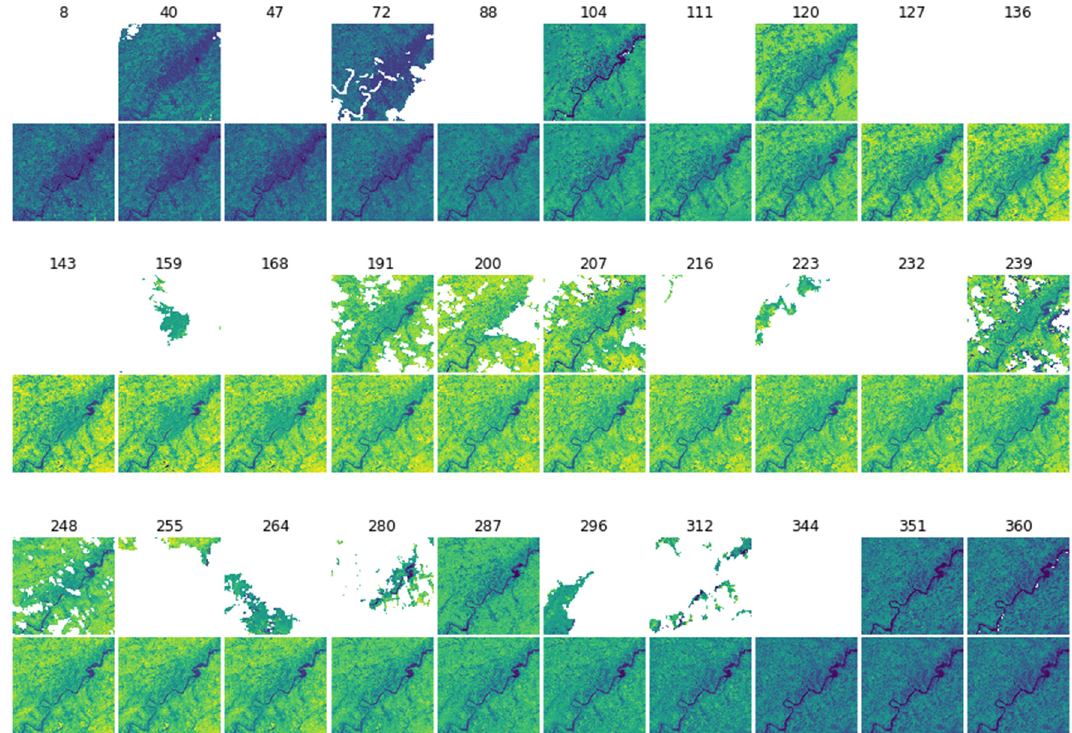
Figure 12. The LAI visual results of SIM (the upper image in each pair is the input and the lower is the output) at the CCN area for all input days. The blanks and gaps in the upper images in each set result from the removal of clouds, cloud shadows, and scan line corrector failure. Table 9. Structural similarity measure (SSIM) between input and output LAI images for the CCN area. DOY